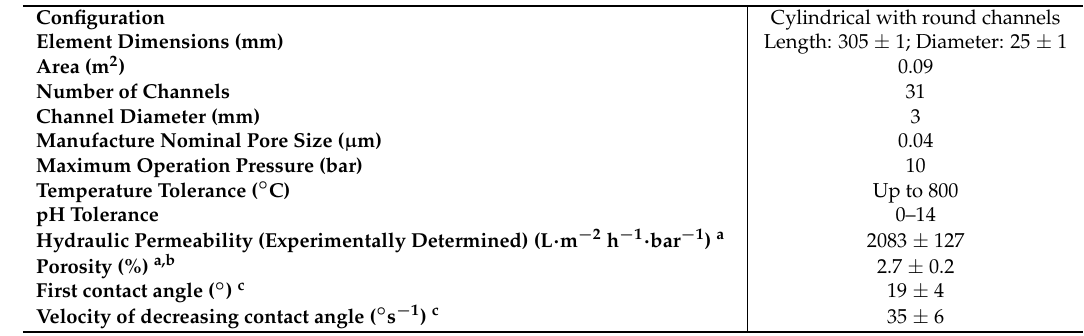
Figure 1. Scheme of the pilot filtration unit with cleaning devices (BP—Backpulse and BW—Backwash) used to treat the real olive mill wastewater in different operation modes (recirculation and concentration tests). Table 1. Characteristics of the silicon carbide (SiC) membrane module used.